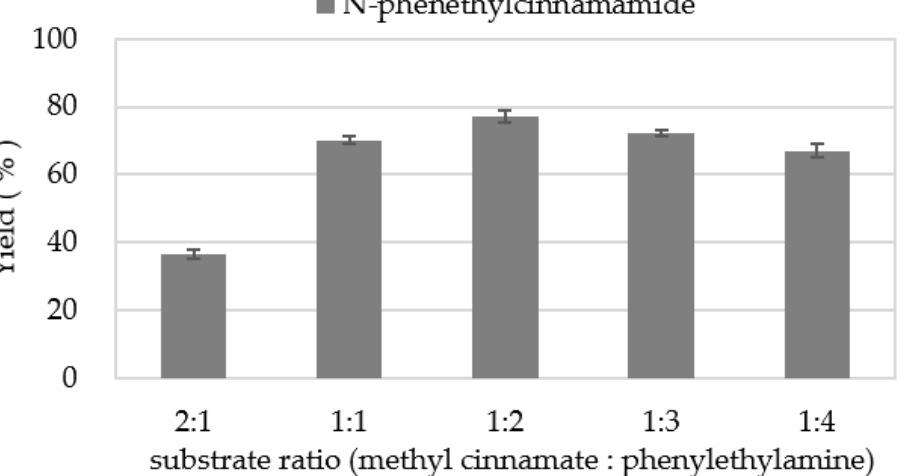
Figure 3. The effect of substrate ratio (methyl cinnamate: phenylethylamine) on the synthesis of N-phenethylcinnamamide catalyzed by Lipozyme ® TL IM in continuous-flow microreactors.